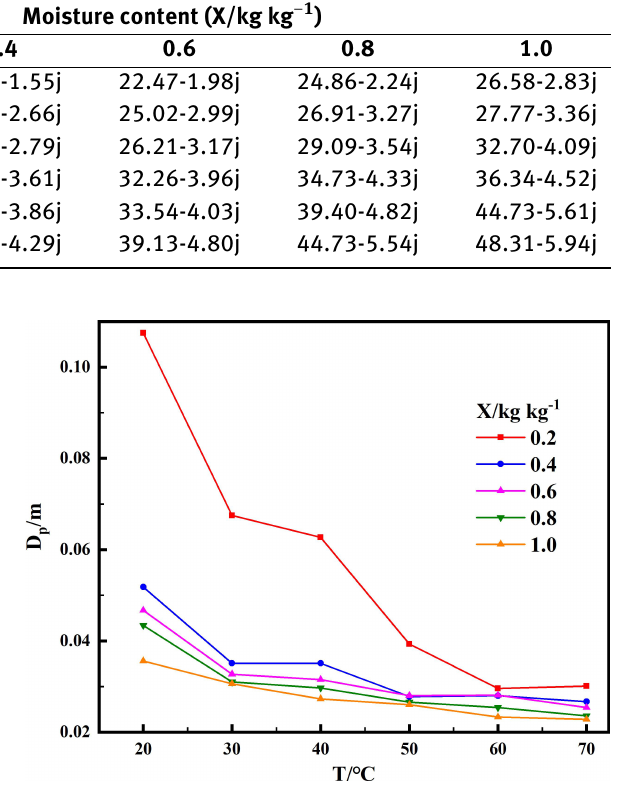
Figure 2: Microwave penetration depth in paracetamol at tempera- tures between 20 and 70 ∘ C and in the moisture contents range of 0.2–1 kg kg −1 (2450